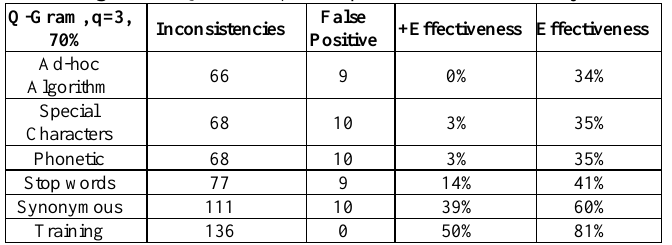
Table 11: Results obtained with data cleaning process using the algorithm Q-Grams, with q=3 and 70% similarity.